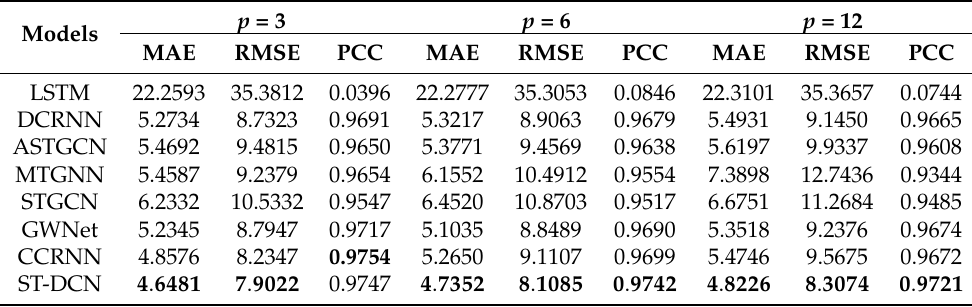
Table 1. Performance comparison of ST-DCN and other baseline models on the NYC taxi dataset.